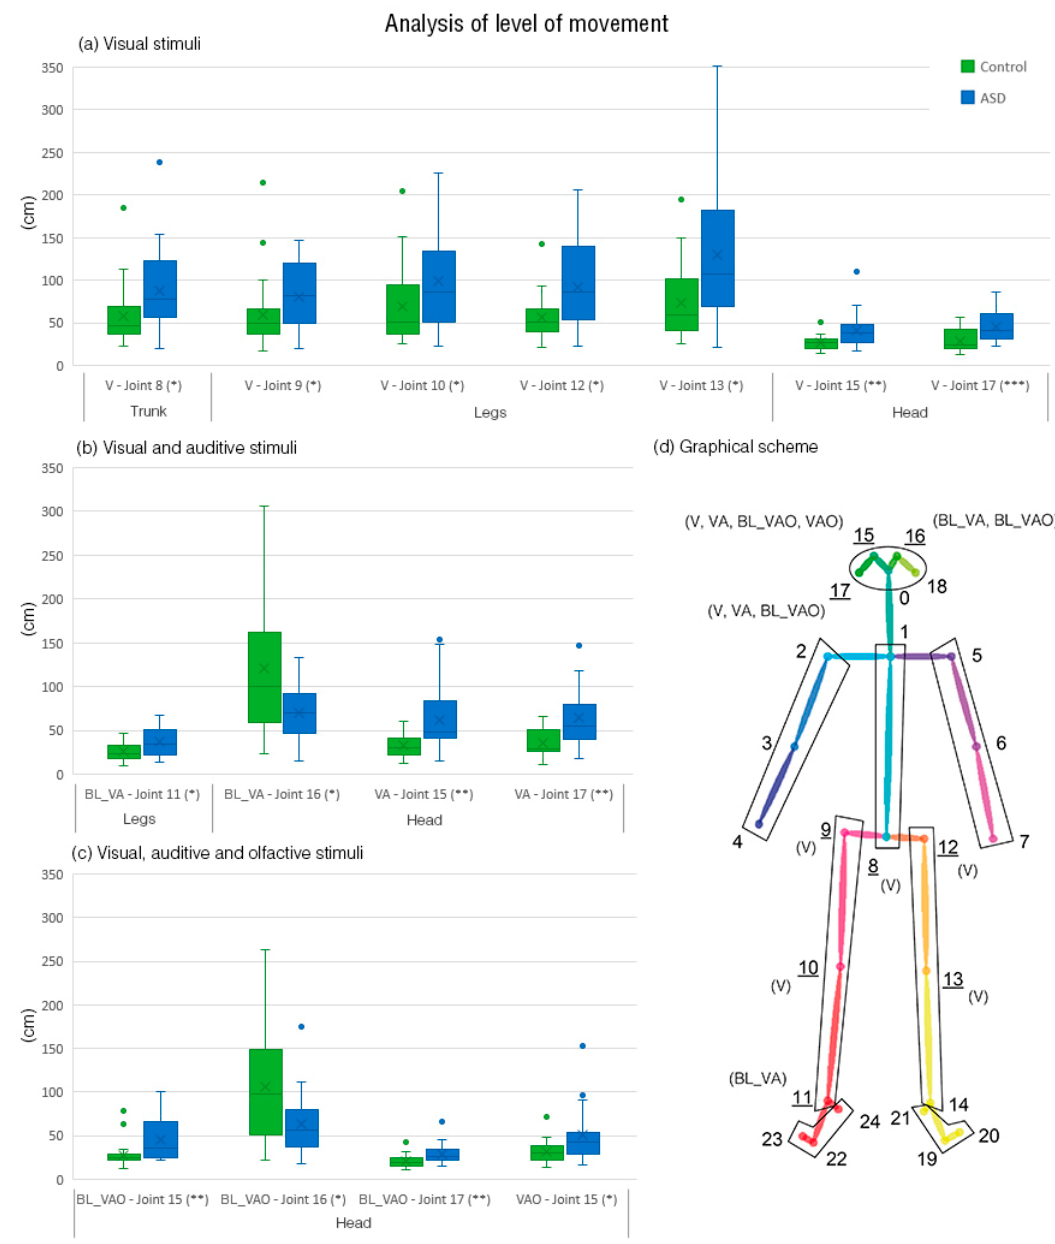
Figure 4. Analysis of the level of movement of joints that presents statistical differences: ( A ) Boxplot of joints in visual stimuli; ( B ) boxplot of joints in visual and auditory stimuli; ( C ) boxplot of joints in visual, auditory, and olfactory stimuli; ( D ) scheme of the joints including the stimuli where differences are found. Note. * p < 0.05. ** p < 0.01. *** p < 0.001.